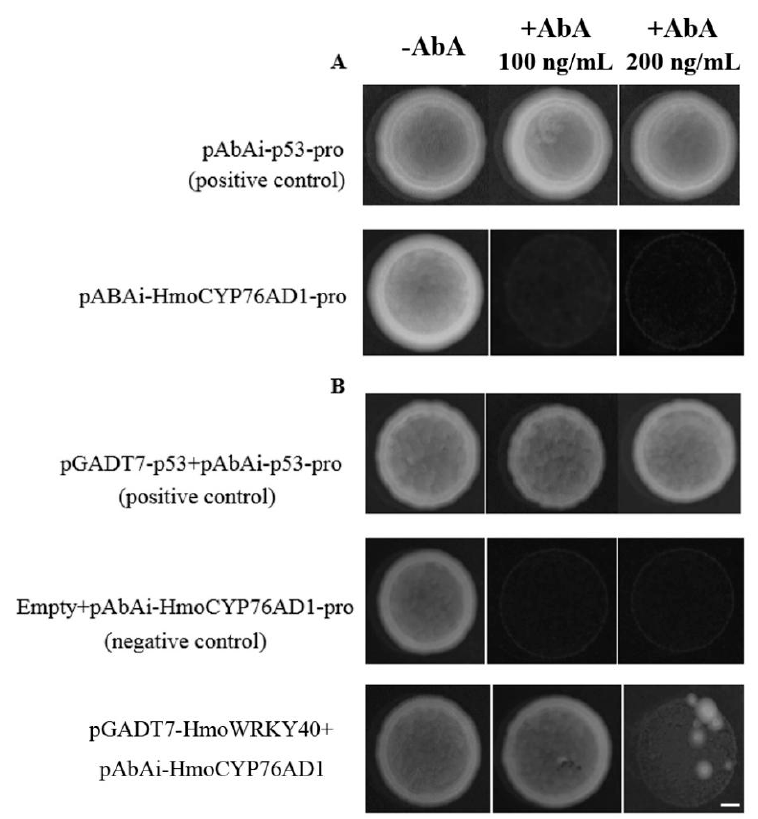
Figure 7. The relationship between HmoWRKY40 and the promoter region of HmoCYP76AD1 by a yeast one-hybrid assay. Bars = 1 mm. ( A ) Self-activation assay of the HmoCYP76AD1A promoters. Yeast cells containing pAbAi-HmoCYP76AD1A-pro transformants were cultured on the SD/-Ura medium supplemented with different concentrations of AbA and ( B ) HmoWRKY40 interacted with HmoCYP76AD1A. Yeast cell transformants of HmoWRKY40 with pAbAi-HmoCYP76AD1A-pro were tested on SD/Leu of AbA at a concentration of 100 and 200 ng/mL. Yeast cells transformed with pGADT7-p53+pAbAi-p53 and pAbAi-HmoCYP76AD1A+pGADT7 were used as the positive and negative control, respectively.